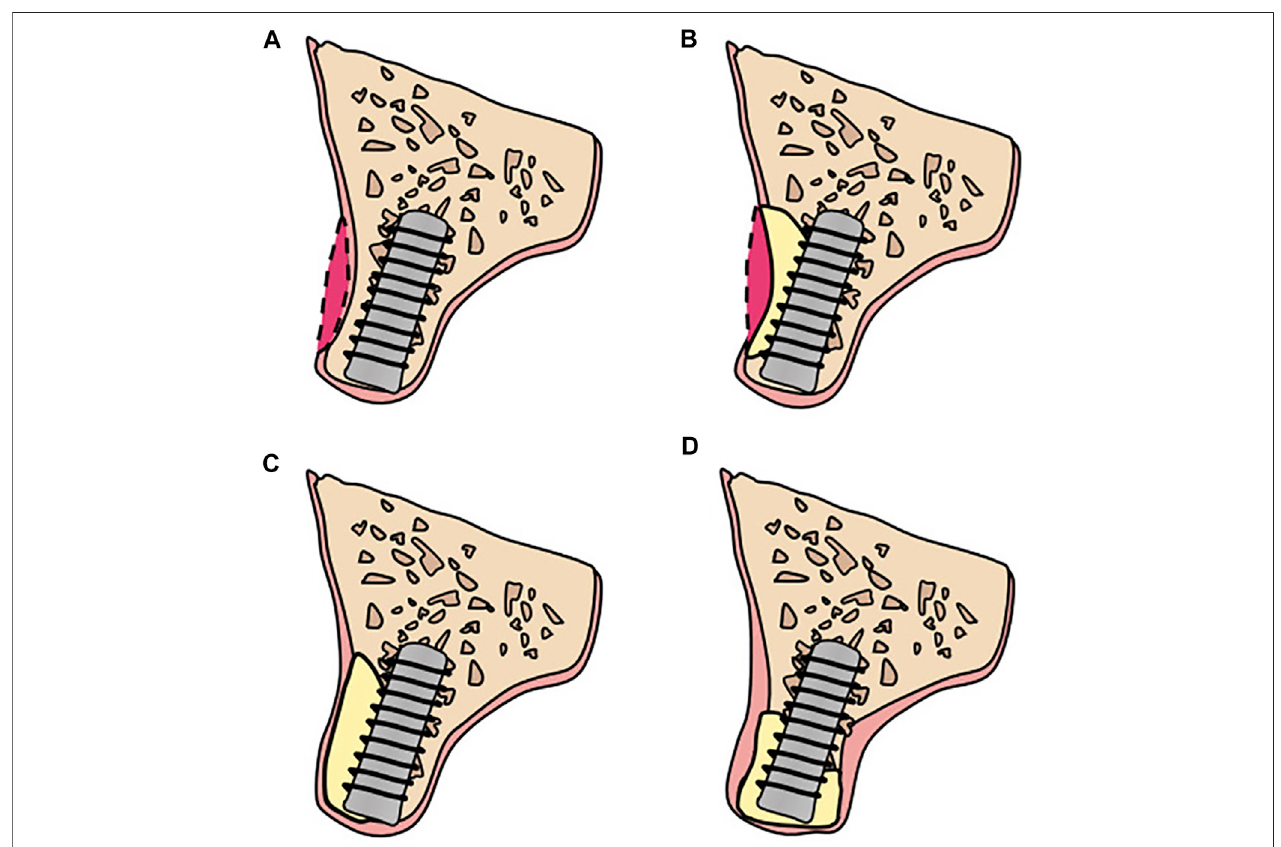
FIGURE 3 | Bone defects classi fi cation: (A) Class 1: ideal alveolar bone condition: implants can be placed in an ideal, restoration-driven location without augmenting the volume of alveolar ridge. Although soft tissue grafts are sometimes recommended; (B) Class 2: a moderate horizontal atrophy: a dehiscence or a fenestration of the buccal plate is present. Implants are placed combined with hard tissue augmentation procedures; (C) Class 3: large degree of horizontal defects: residual alveolar ridge allows for a two-stage implant placement. Suf fi cient bone graft volume and adequate healing time are indispensable; (D) Class 4: severe atrophy on height and width: the remaining alveolar bone is in poor condition and there are commonly two alternatives: (i) onlay bone grafting; (ii) GBR with autogenous particulate bone and/or xenogeneic bone using Ti mesh.